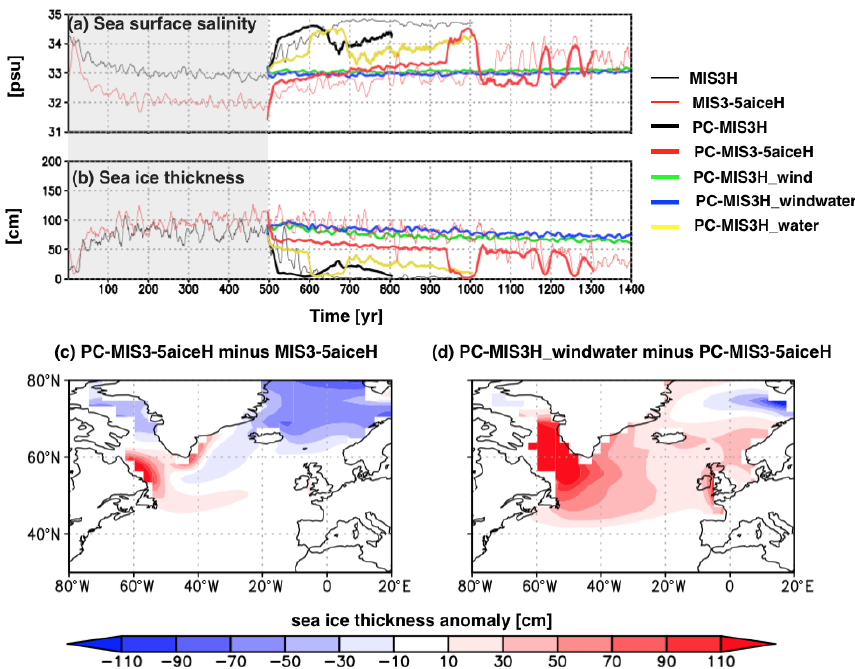
Figure 12. Changes in sea surface conditions obtained from partially coupled experiments. Temporal evolution of February sea surface salinity (psu, a ) and February sea ice thickness (cm, b ) over the Irminger Sea (55–63 ◦ N, 35–25 ◦ W; left). Thin black: MIS3H, thin red: MIS3–5aiceH, thick black: PC-MIS3H, thick red: PC-MIS3–5aiceH, thick green: PC-MIS3Hwind, thick blue: PC-MIS3Hwindwater, thick yellow: PC-MIS3Hwater. Freshwater flux of 0.1Sv is applied during years 0 to 500 (gray-shaded period). (c, d) Spatial maps of annual mean sea ice thickness (cm) averaged over years 501–600. Panel (c) shows the differences between a partially coupled experiment (PC-MIS3– 5aiceH) and the corresponding original experiment (MIS3–5aiceH); panel (d) shows the effect of surface cooling by the MIS3 ice sheet (difference between PC-MIS3H_windwater and PC-MIS3–5aiceH). For panels (a) and (b) , 11-year running means are